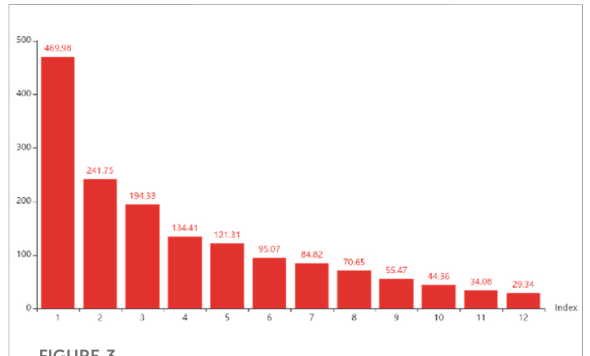
FIGURE 3 Distribution of eigenvalues of single-phase grounding faults after dimensionality reduction using the PCA method.